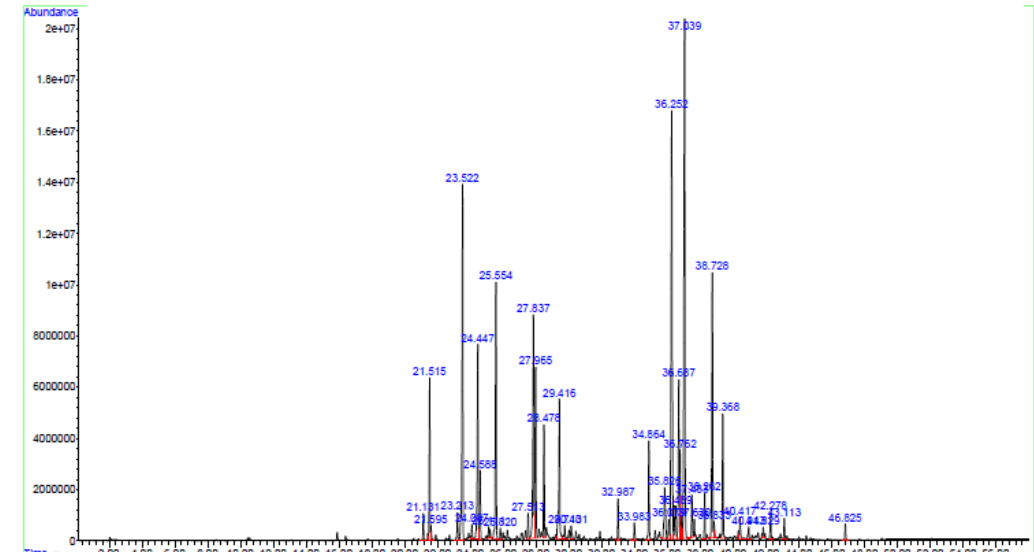
Figure 3. Gas chromatogram of the essential oil of ‘Çakmar’ purple flowers